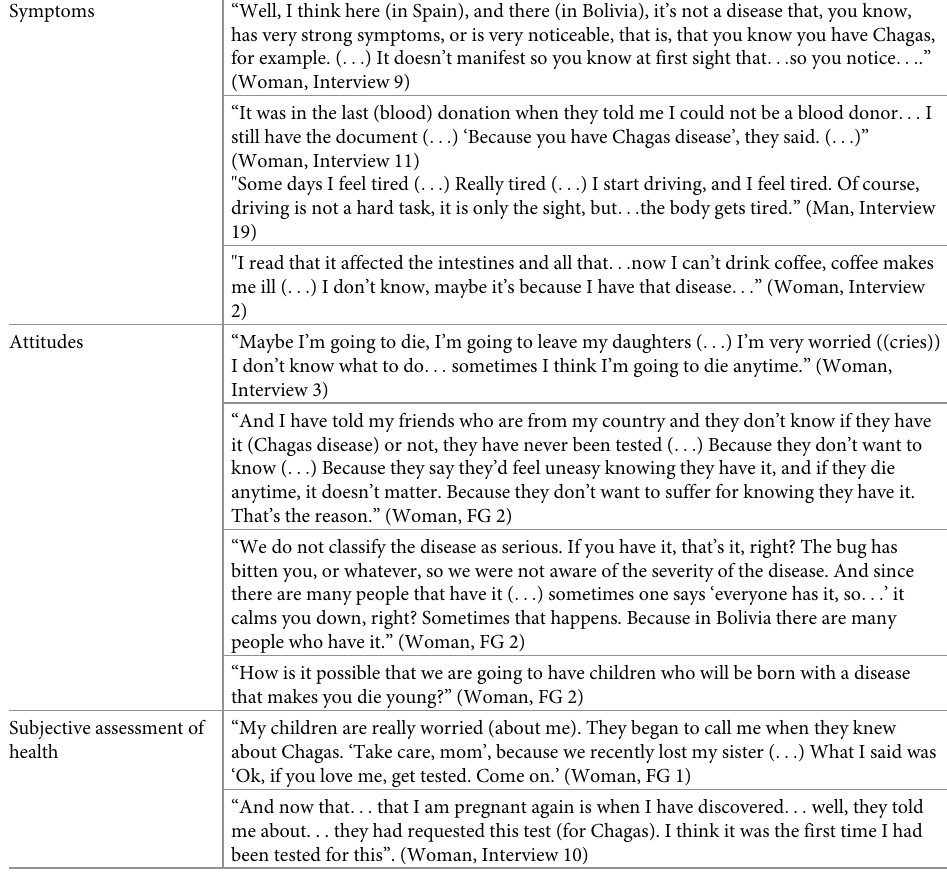
Table 7. Quotes related to need.